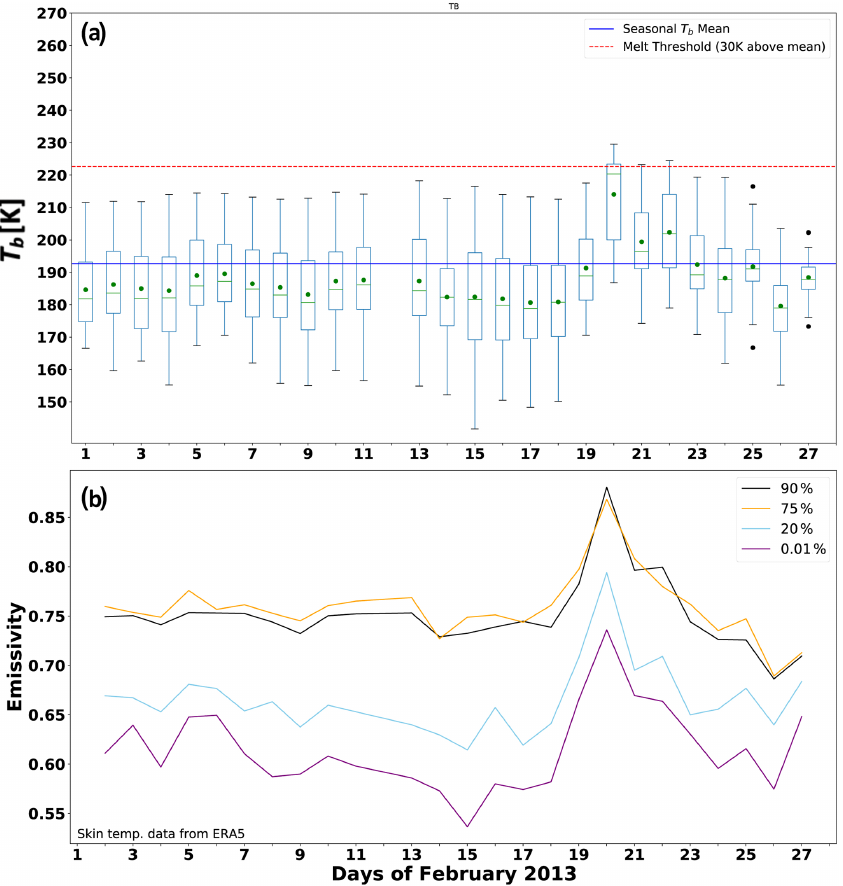
Figure 11. As in Fig. 3 but over the Pine Island and Thwaites Glacier region throughout February 2013. The five estimates of surface emissivity sampled in panel (b) from the region are referenced to the maximum T b value in the region on 20 February.